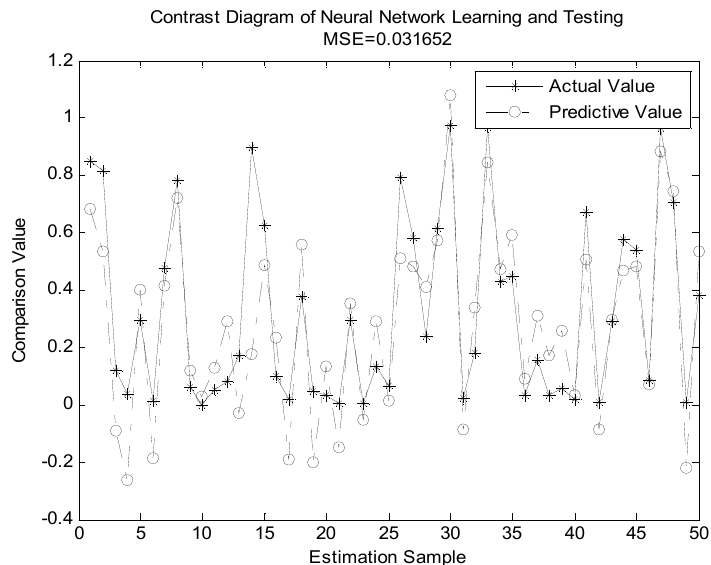
Figure 10. Actual and predictive outputs of locally weighted linear regression (LWLR).